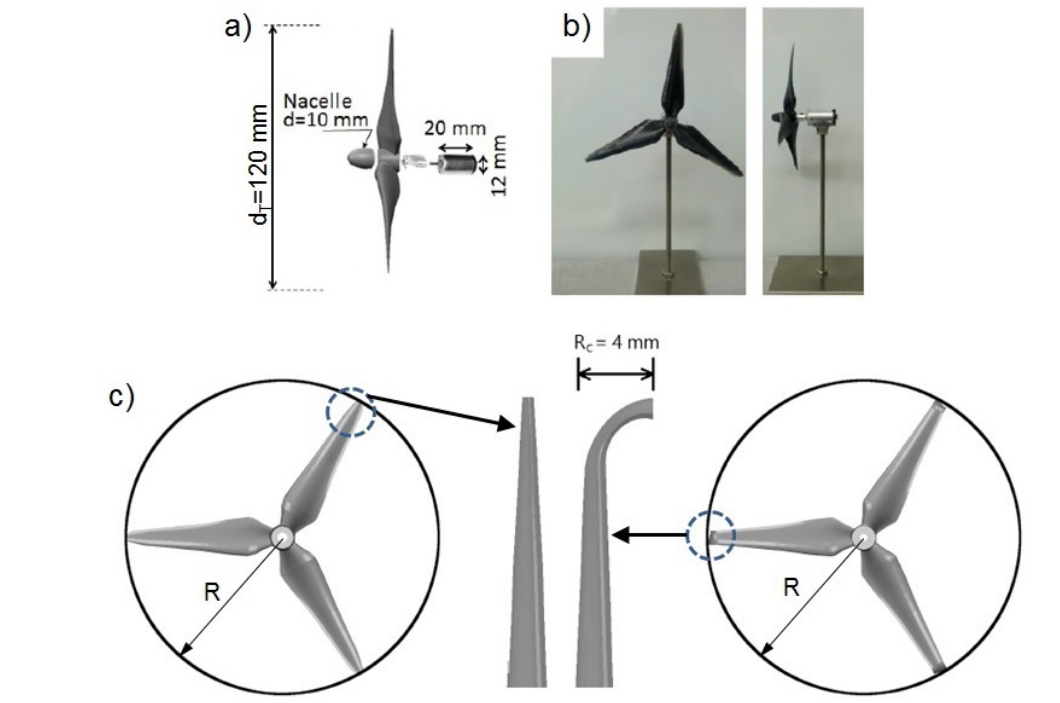
Figure 1. Schematic of the miniature turbine. ( a ) schematic of rotor, nacelle and loading system; ( b ) base miniature wind turbine; ( c ) standard and wingletted rotor